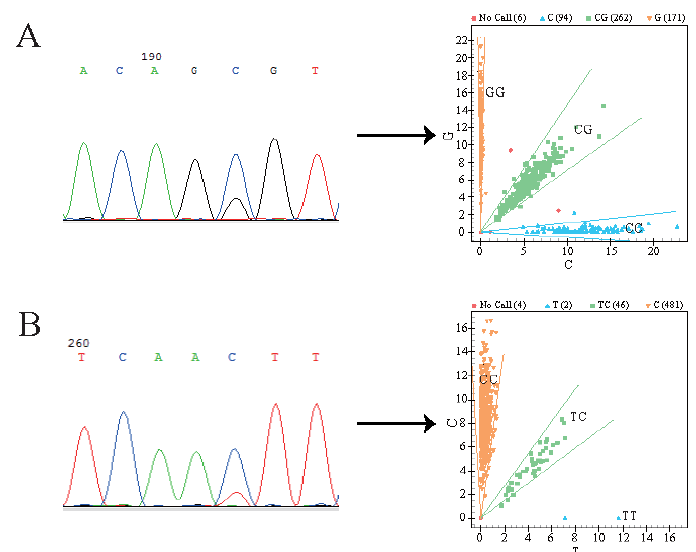
Figure 1. P DGF-D gene pool sequencing and genotyping results. ( A ) Site of g.4122606 C > G. ( B ) Site of g.3852134 C > T. Yellow region, blue region, and green region represent different genotypes. Numbers in brackets indicate number of individuals of the three genotypes.